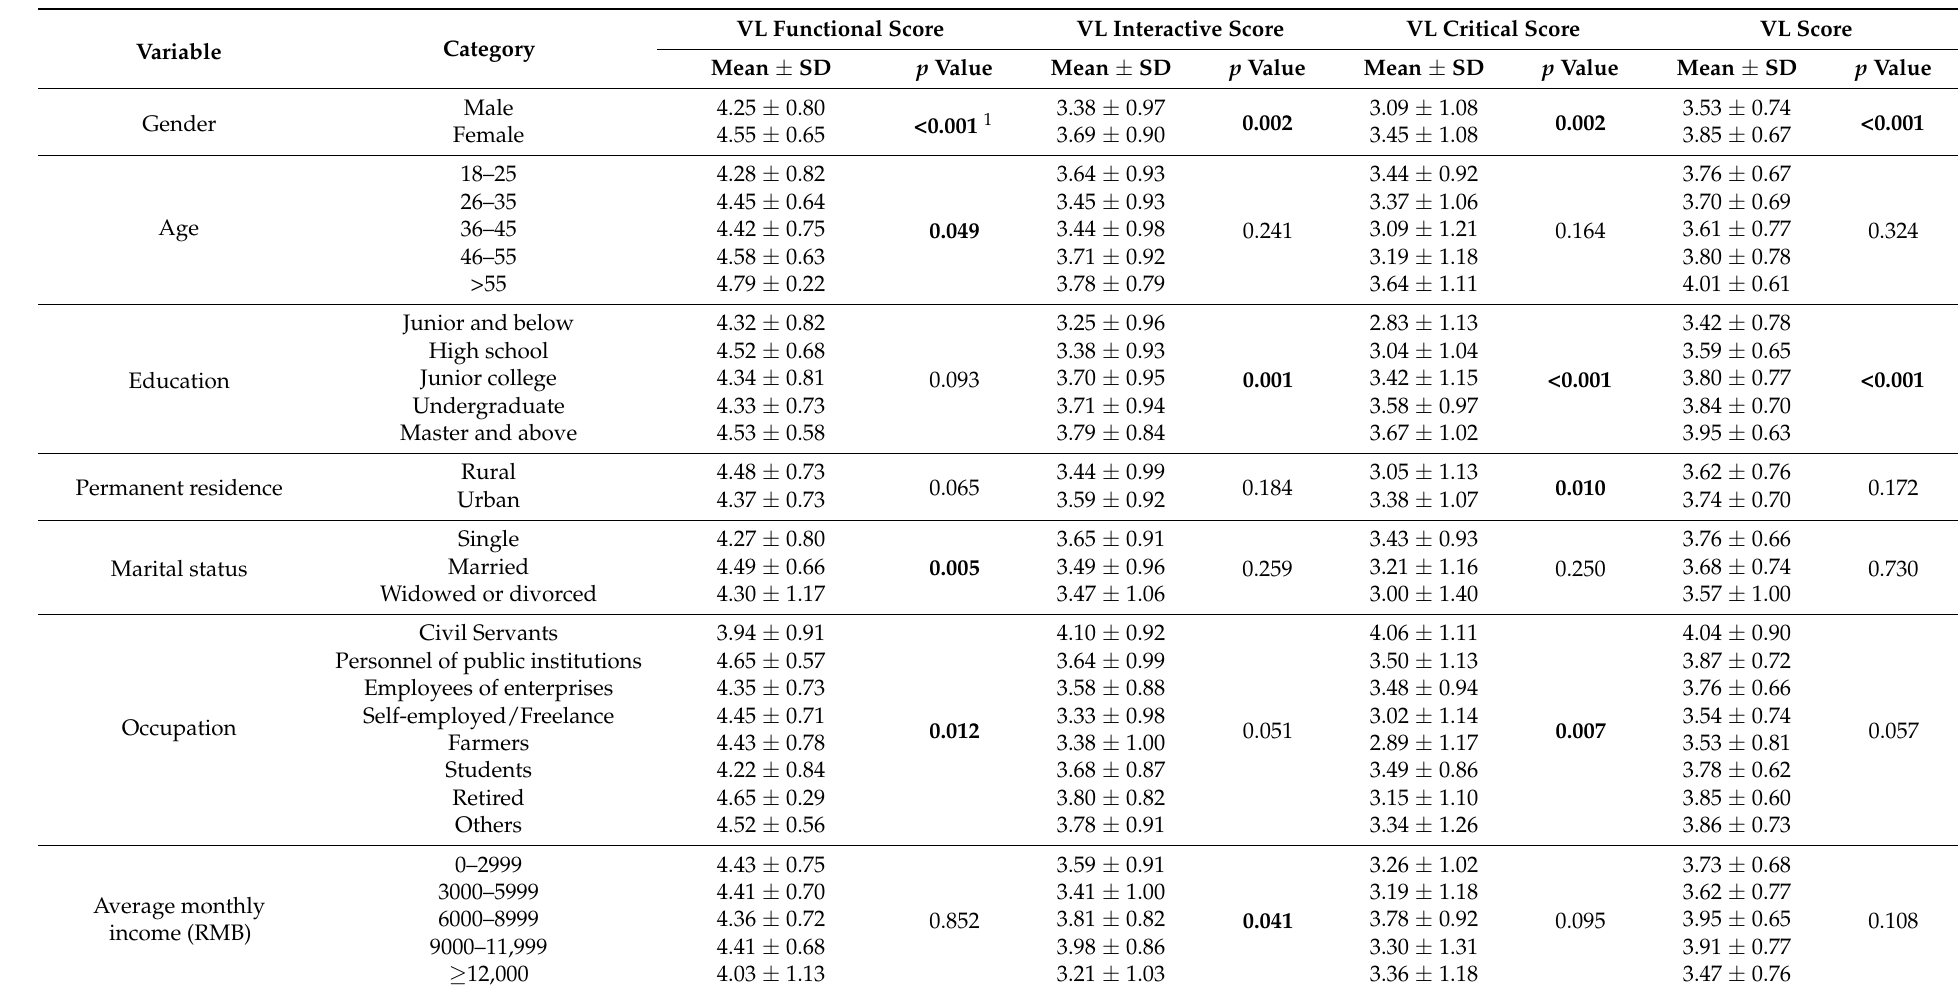
Table 4. Relationship between sociodemographic characteristics and COVID-19 vaccine